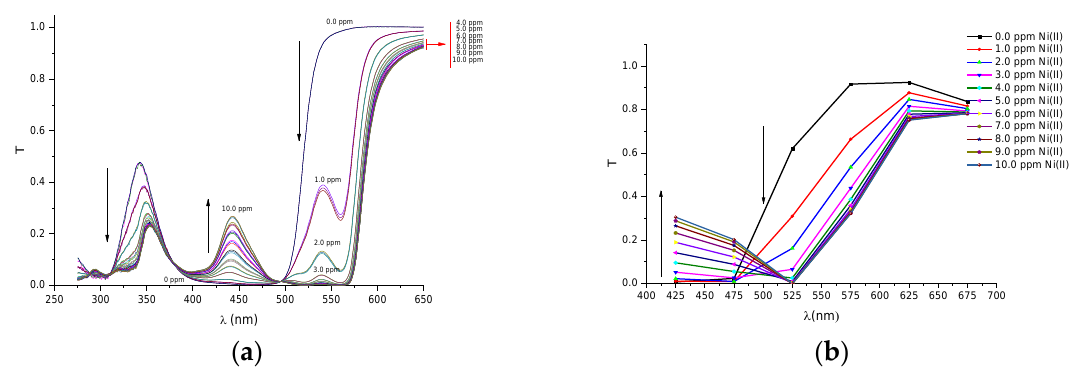
Figure A6. The transmittance spectra of the chromogen reagent of 1-(2-pyridylazo)-2-naphthol (PAN) solution containing Ni(II) ions at different concentrations corresponding to: ( a ) The UV-VIS Cary ® 50-Varian spectrometer ( b ) the multiespectral MMCS6CS sensor.